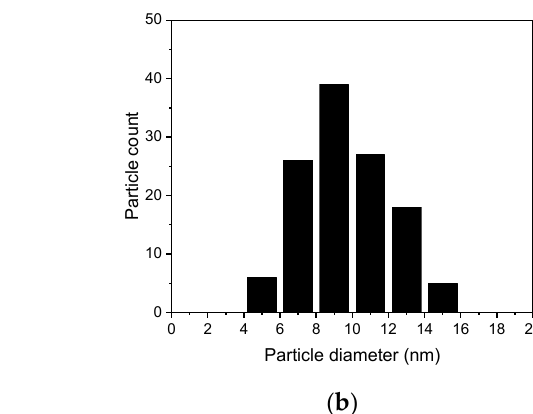
Figure 1. ( a ) Transmission electron microscopy (TEM) microphotography of bare iron oxide nanoparticles (MNPs) and ( b ) the size distribution of the particles on the right.